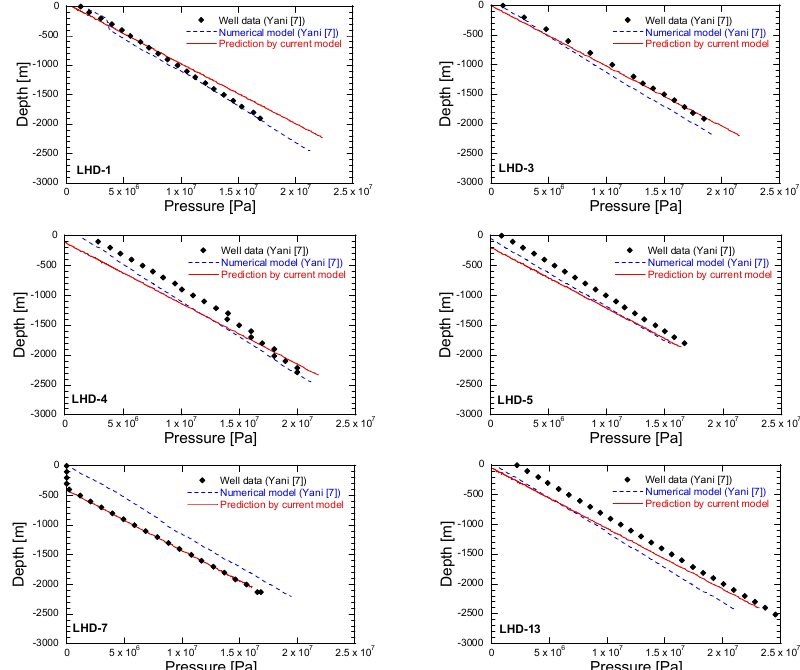
13, have a lower pore pressure than the actual measured data, almost all of the predicted pore pressure values match closely with the actual measured data.